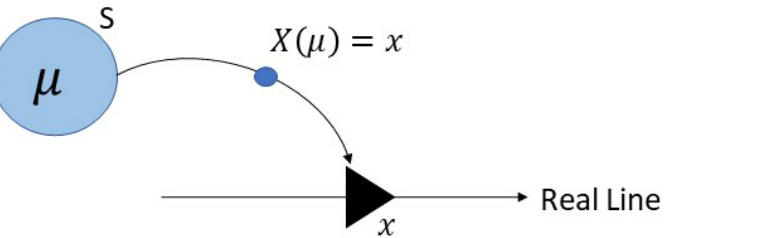
Figure 6. A random variable assigns a number X ( µ ) to each outcome µ in the sample space S of a random experiment [x].